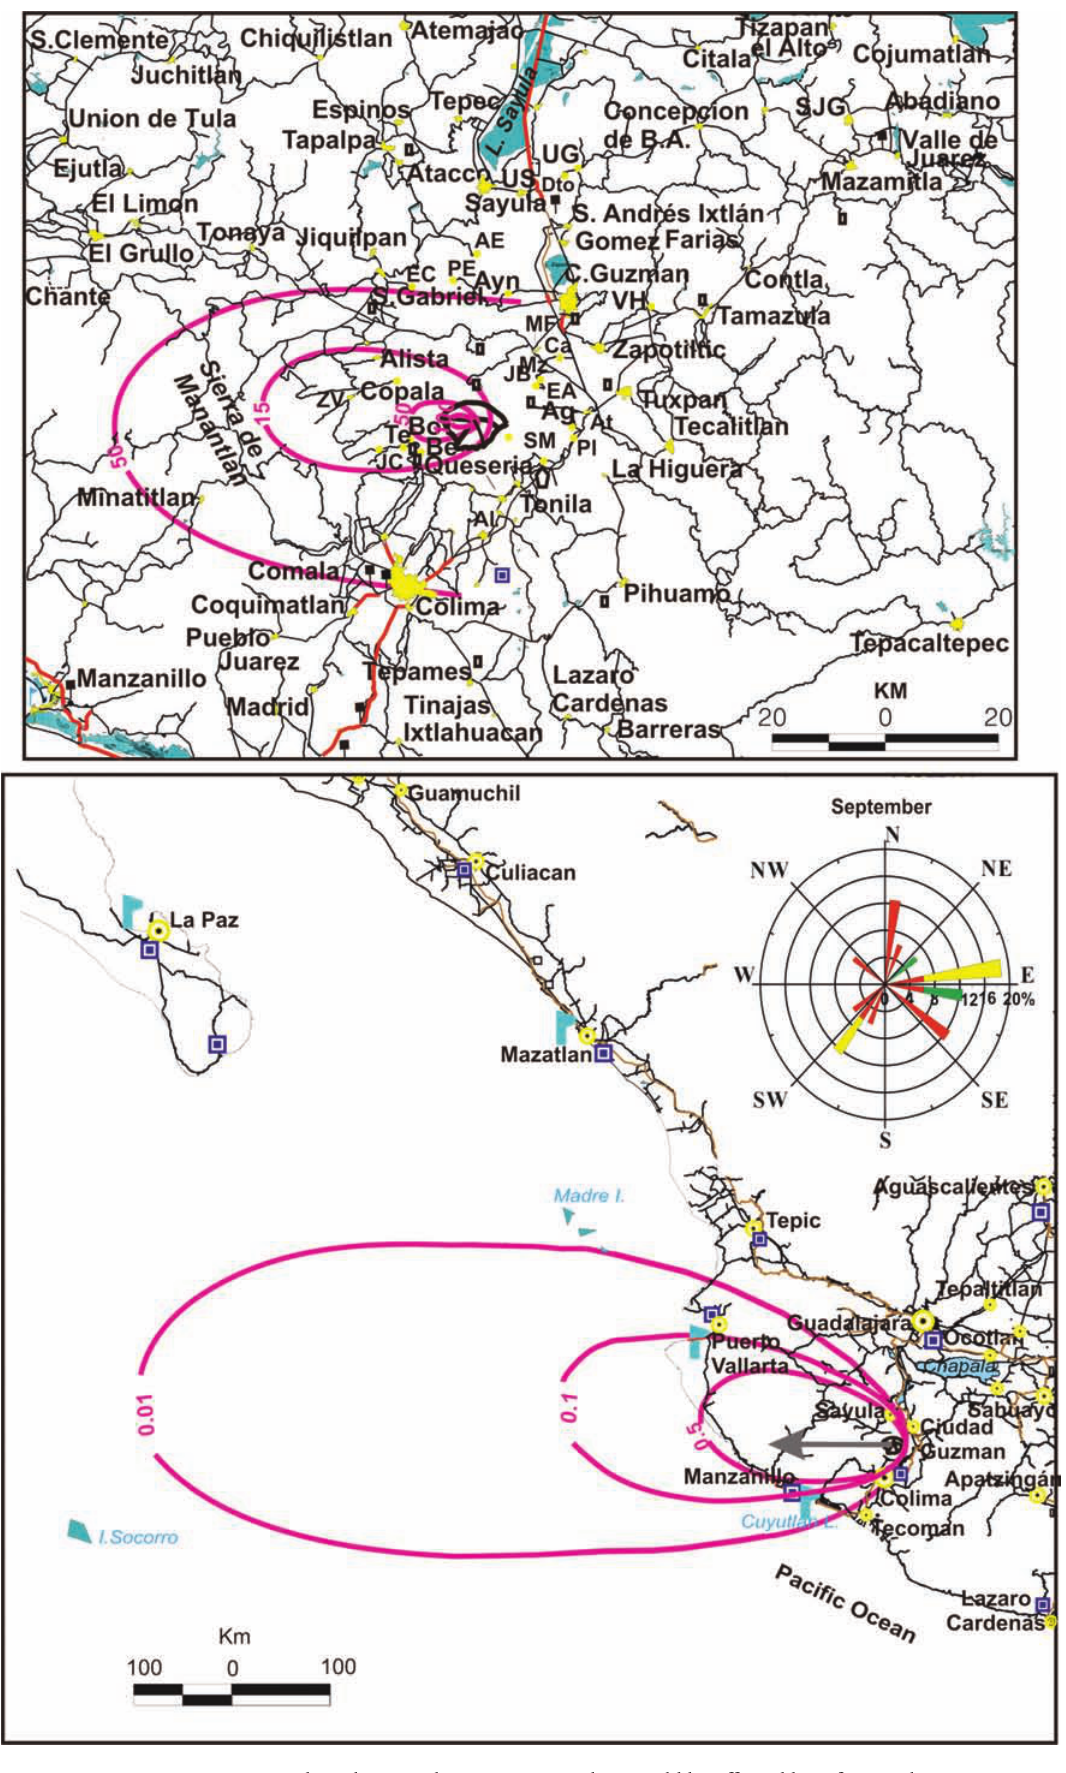
Figure 9. Scenario 6. For an eruption in September, showing the western area that would be affected by a future Plinian eruption. For details, see legend to Figure